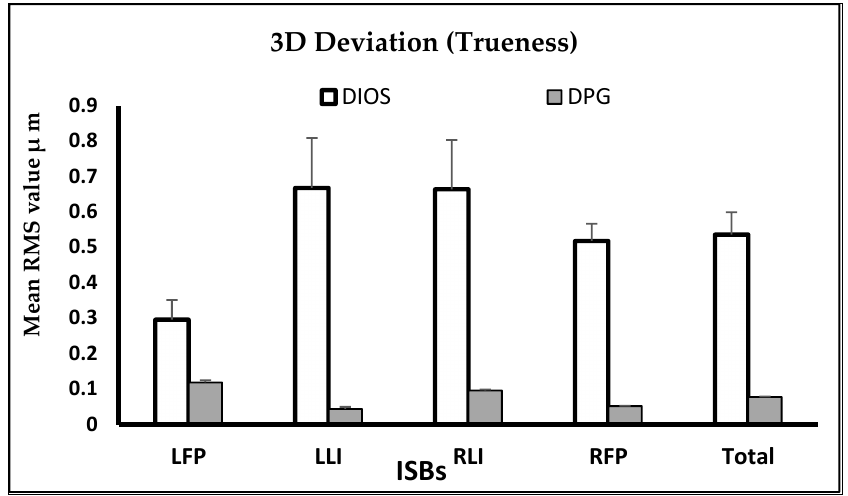
Figure 6. Trueness of intraoral scan bodies in terms of 3D deviation. RMS, root mean square; ISBs, intraoral scan-bodies; LFP, left first premolar; LLI, left lateral incisor; RLI, right lateral incisor; RFP, right first premolar; DIOS, digital intraoral scanning; DPG, digital photogrammetry. Table 2. Means and standards deviations of RMS 3D distortions among implant level impression techniques in terms of precision. RMS 3D ISBs Deviation for Precision (Mean ± SD) ISBs DIOS ( n = 15)